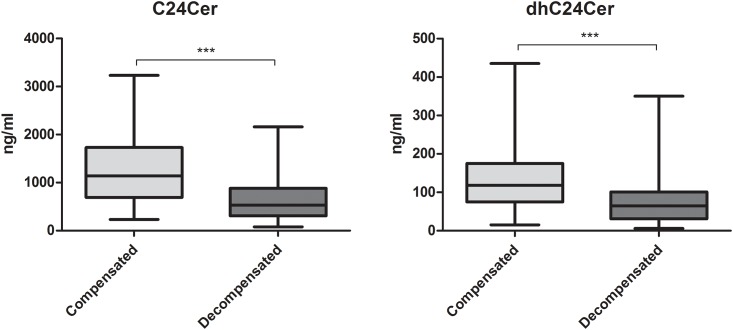
Serum C24Cer and dhC24Cer levels are decreased in decompensated cirrhosis.Serum concentrations of C24Cer and dhC24Cer show a considerable decline in patients with decompensated cirrhosis as compared to patients with compensated cirrhosis (p<0.001). Cer: ceramide.